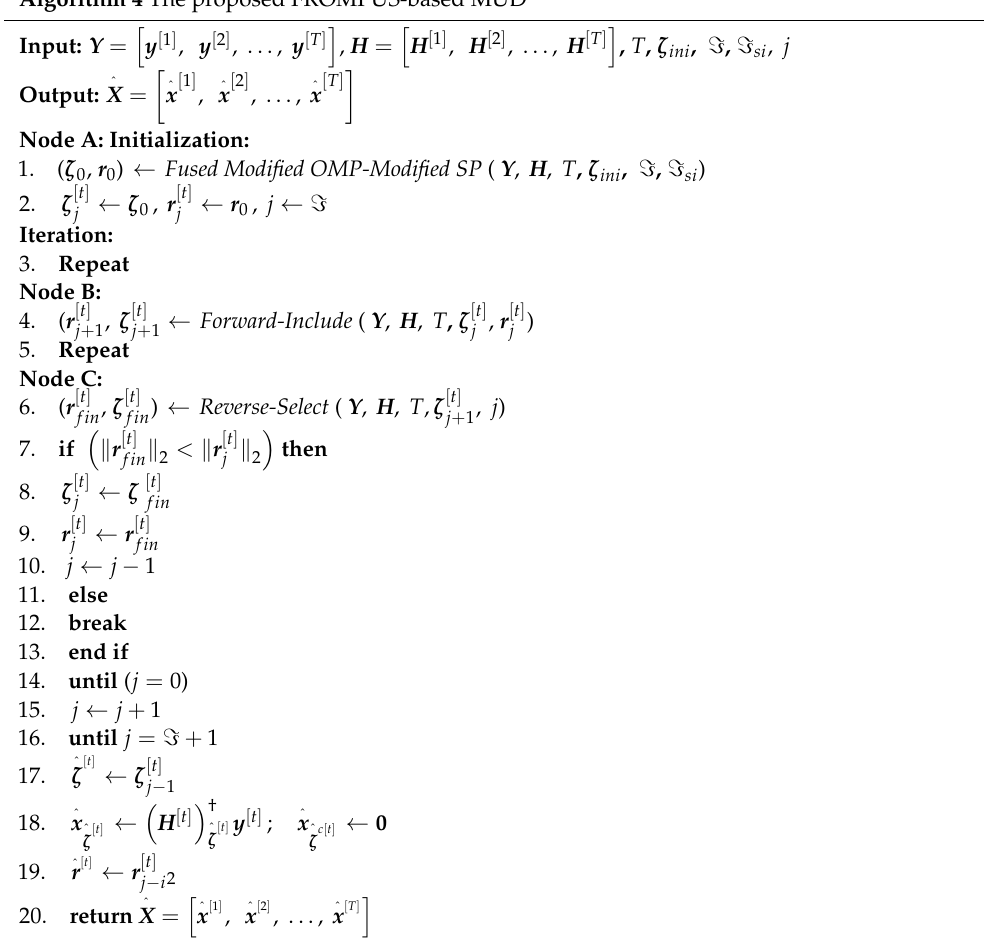
Algorithm 4 The proposed FROMPUS-based